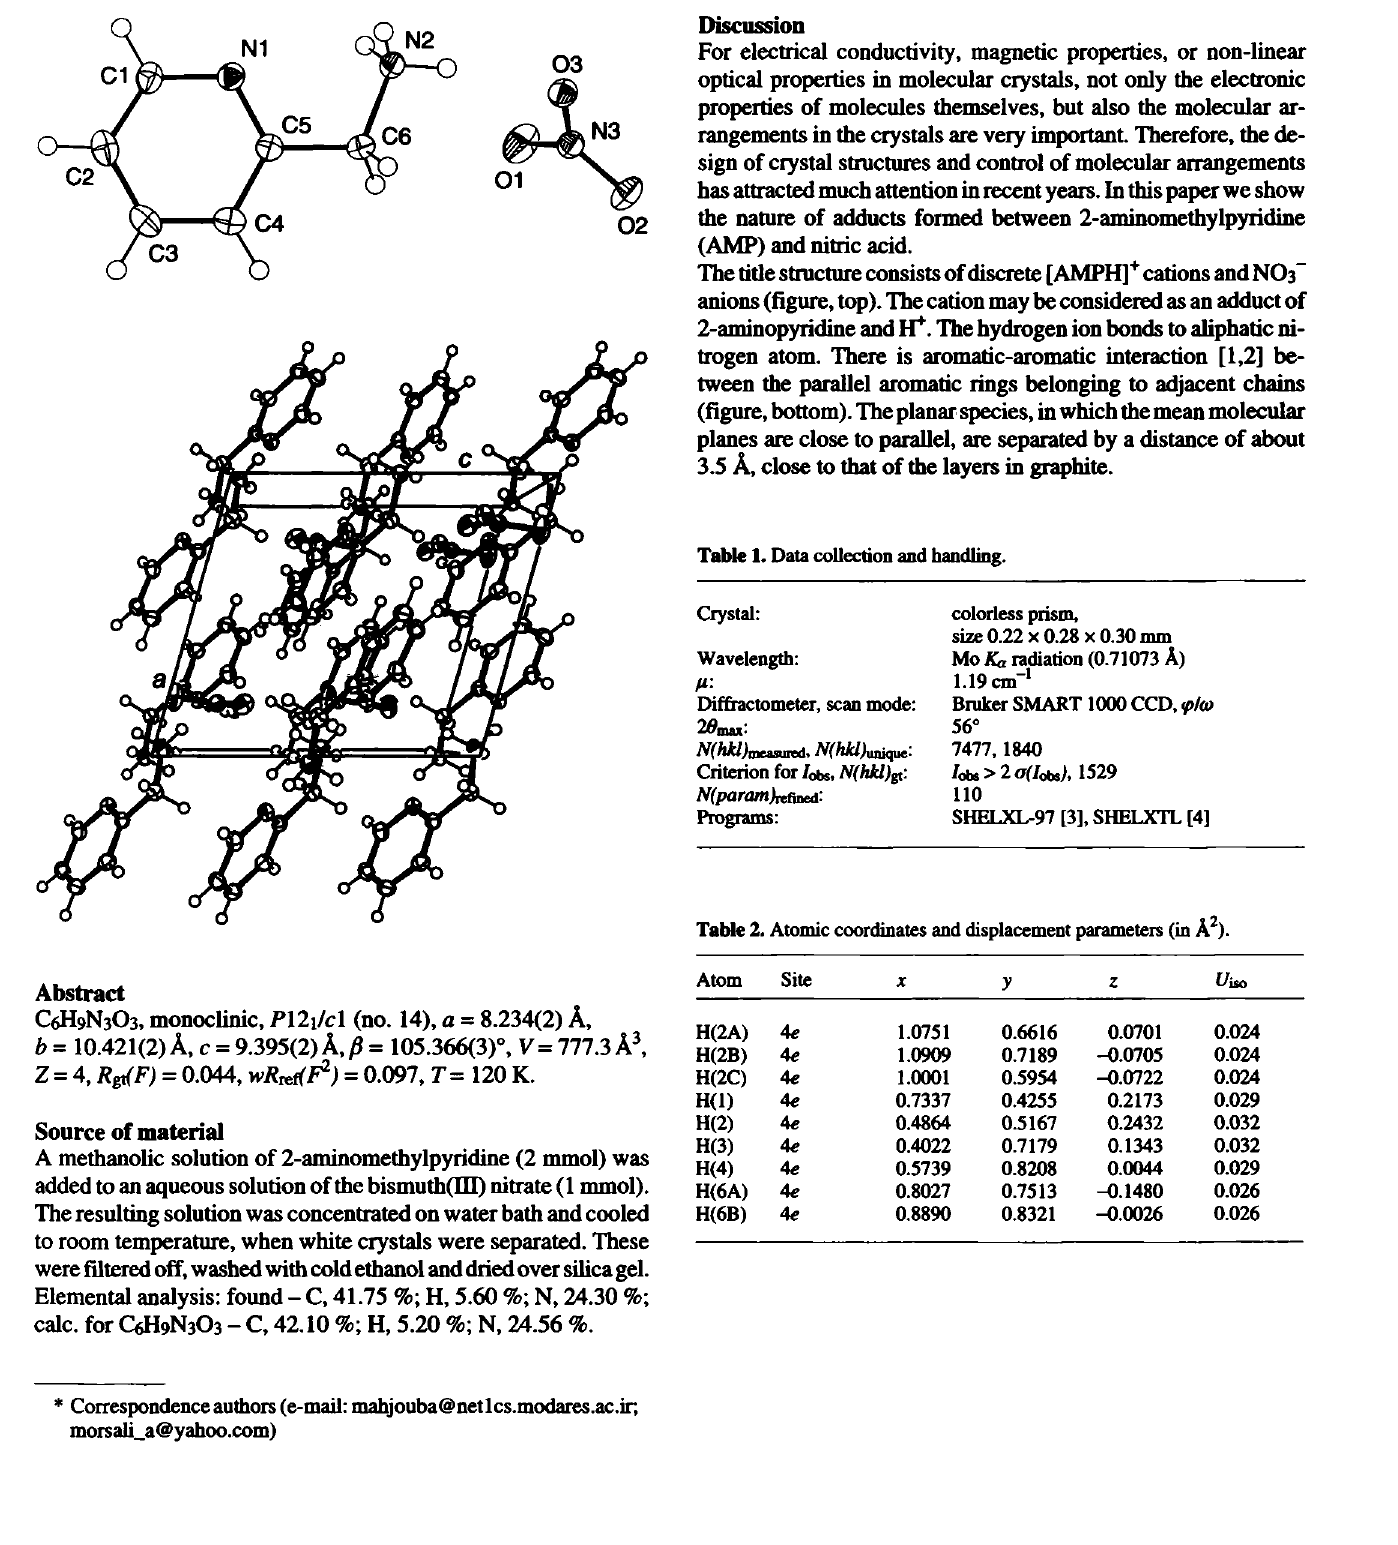
Table 1. Data collection and handling.